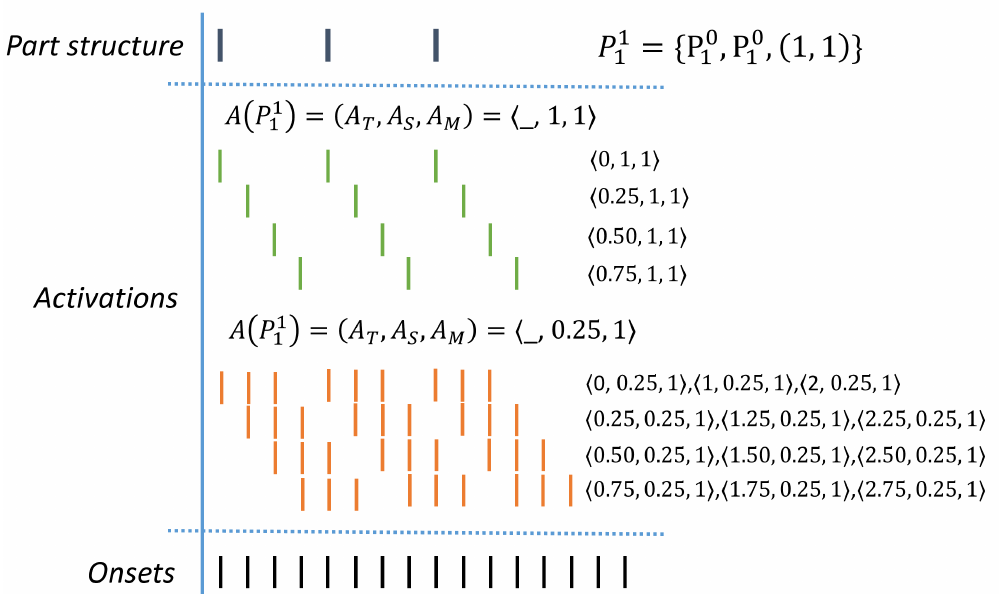
Figure 8. The example shows overlapping activations of a single P 1 to efficiently reduce such overlapping